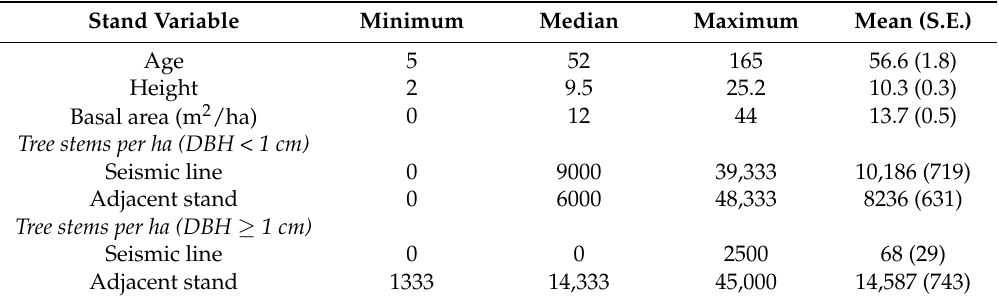
Table 1. Stand characteristics and tree regeneration rates for 127 sites (254 plots) sampled in northeast Alberta, Canada. S.E. is standard